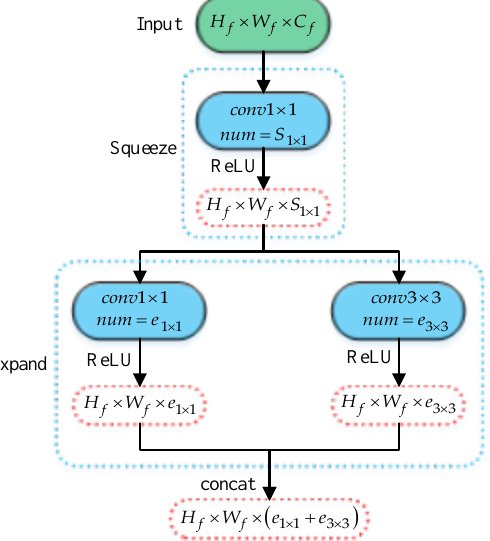
Figure 2. The organization of the convolution filters in the Fire module. The red boxes drawn with a dotted line defines the dimension of the output characteristics of each convolution layer.